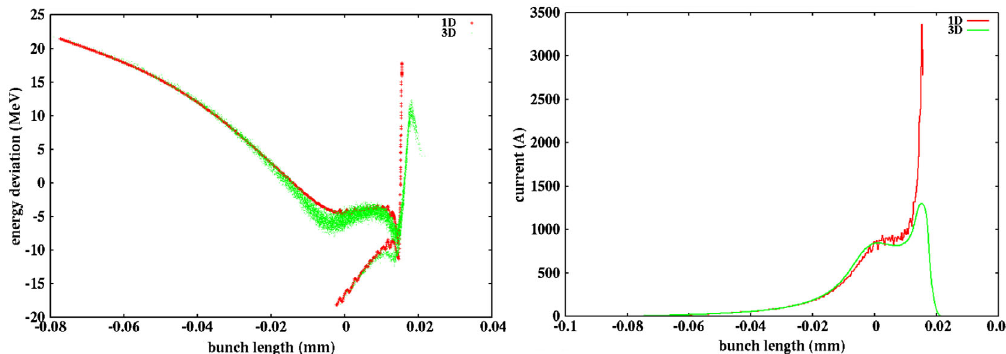
FIG. 5. Longitudinal phase space distribution (left) and current profile (right) at the entrance to undulator from the 1D model (red) and from the 3D model